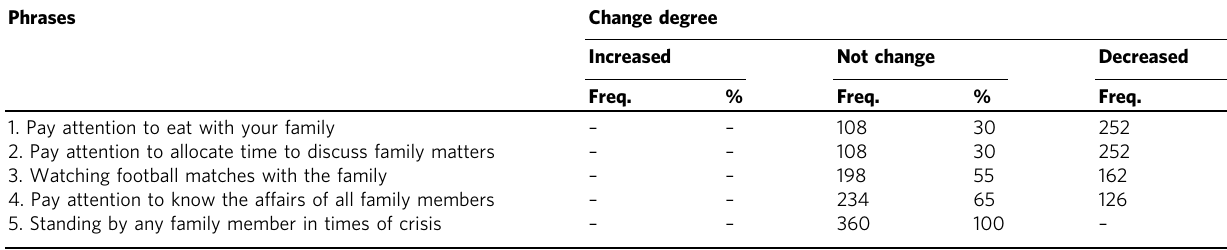
Table 8 Respondents ’ responses according to the change in the cultural identity component of family